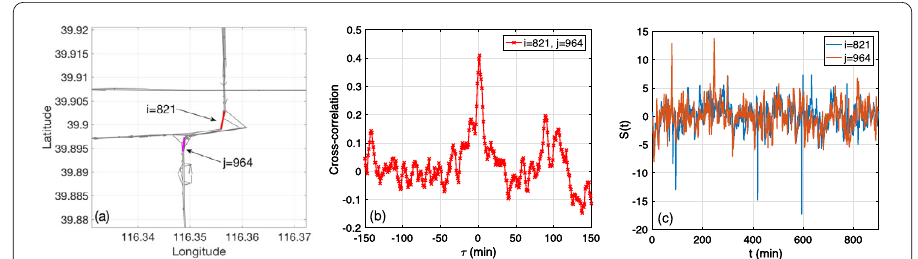
Figure 2 Demonstration of a typical strong link. During the dates 26–30 Oct. 2015 in RH1. The two road sections (nodes) are i = 821, j = 964 (See ( a )), with W pos i , j = 4.47. ( a ) The location of the two nodes on the map. The red and the magenta lines indicate the two road sections i and j . ( b ) Cross-correlation X i , j ( τ ) VS τ . The maximum correlation is 0.4102, at time lag τ = 2 (minutes). ( c ) Shifted time series for the example in ( a , b ). For this link, the peak of the cross-correlation function at τ = 2 (minutes) suggests an influence with a clear direction from i to j